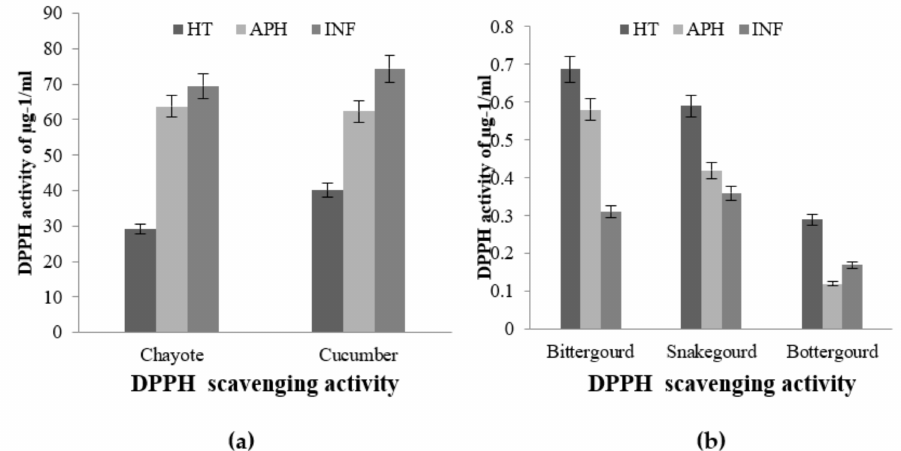
Figure 3. DPPH scavenger of a free radical assay from healthy (HT), apparently healthy (APH), and infected (INF) tissues: ( a ) cucumber and chayote fruit tissues; ( b ) bitter gourd, snake gourd, and bottle gourd during melon fly infestation. The vertical bars indicate the standard error. Significance at p ≤ 0.05.